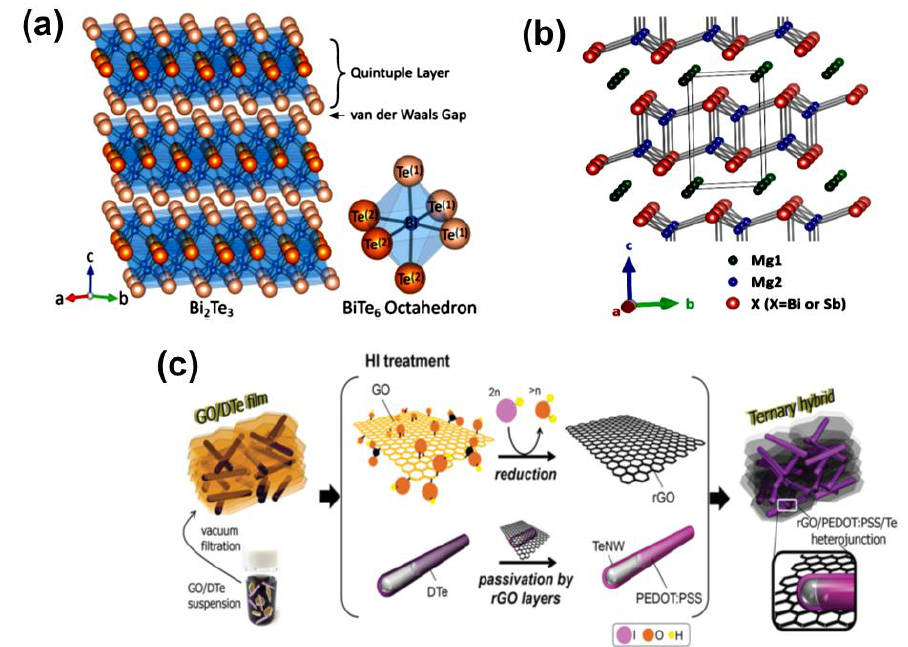
Figure 4. ( a ) Atomic structures of a bulk unit cell of Bi 2 Te 3 , adapted with permission from [14]. ( b ) Crystal structure of Mg 3 X 2 system adapted with permission from [44]. ( c ) Schematic illustration of designed ternary TE composites adapted with permission from [51].